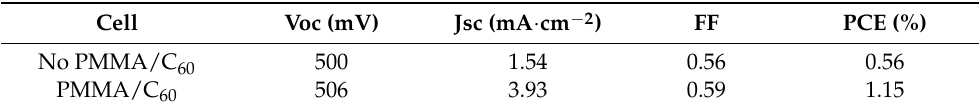
Table 1. Solar cell parameters of nanocarbon-based solar cells [78]. PMMA/C 60 = poly(methyl methacrylate)/fullerene C 60 ; PCE = photo-conversion efficiency; Jsc = short-circuit current density; Voc = open-circuit voltage; FF = fill factor. Reproduced with permission from ACS.